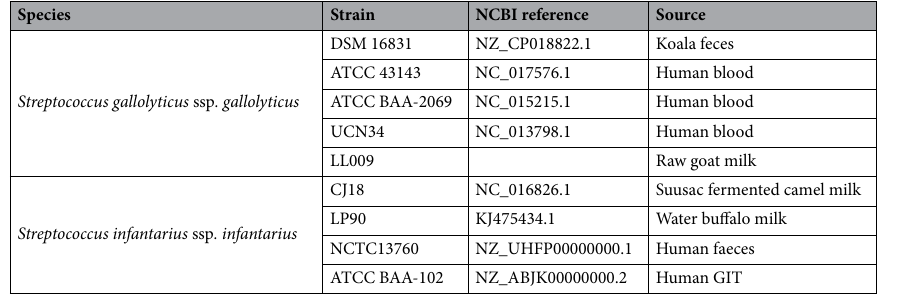
Table 3. Genomes analysed in this